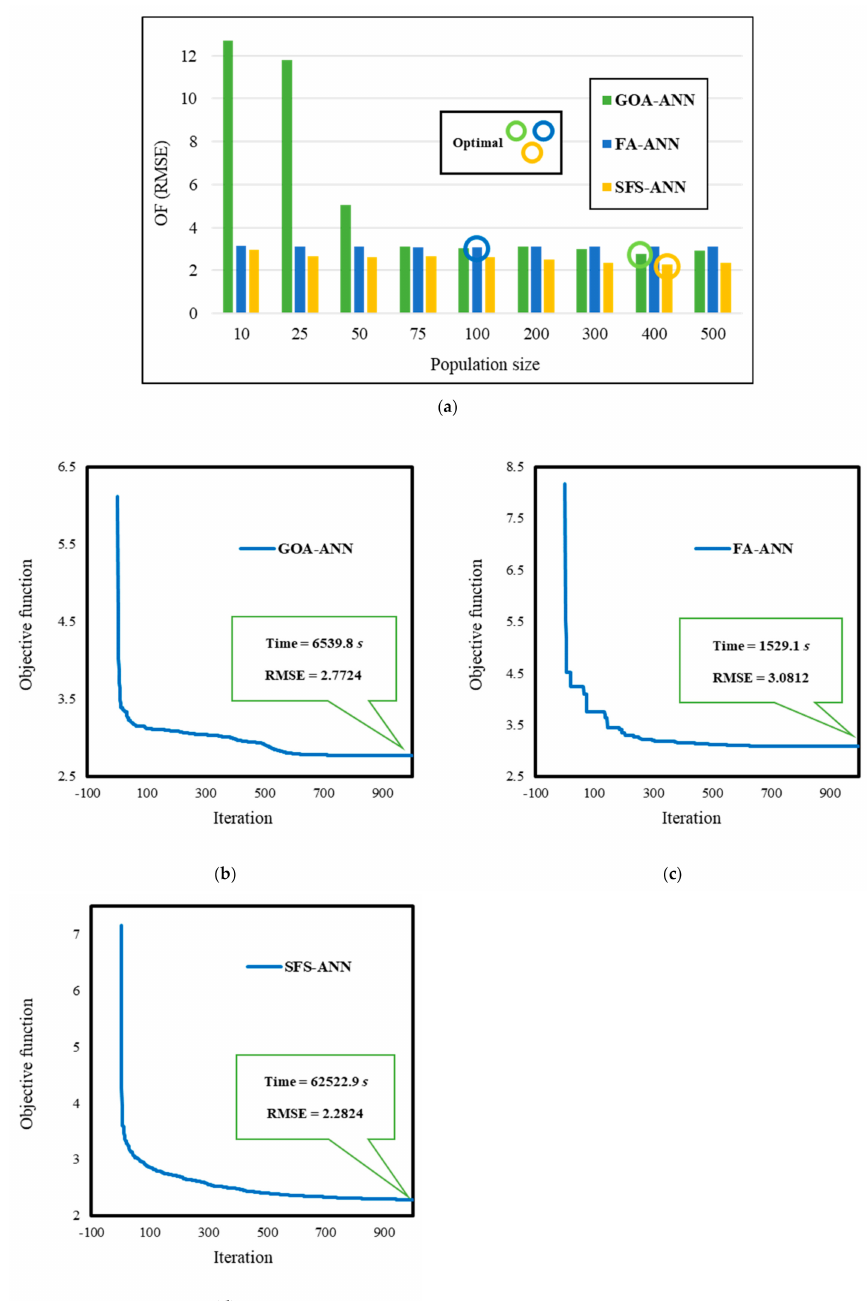
Figure 4. ( a ) Sensitivity analysis and ( b – d ) best optimization